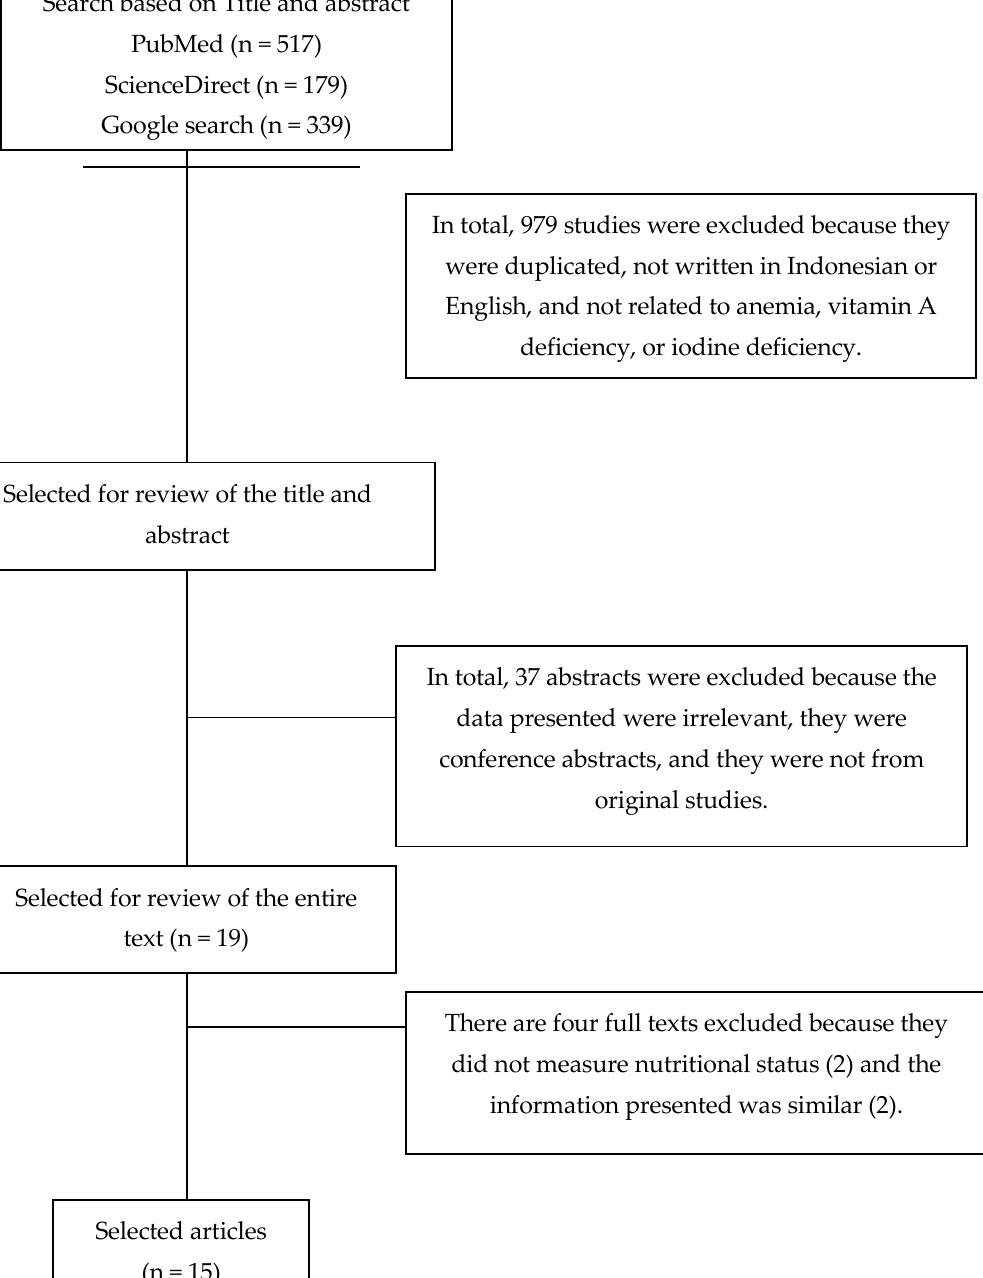
Figure 1. CONSORT diagram of the literature search and determination.